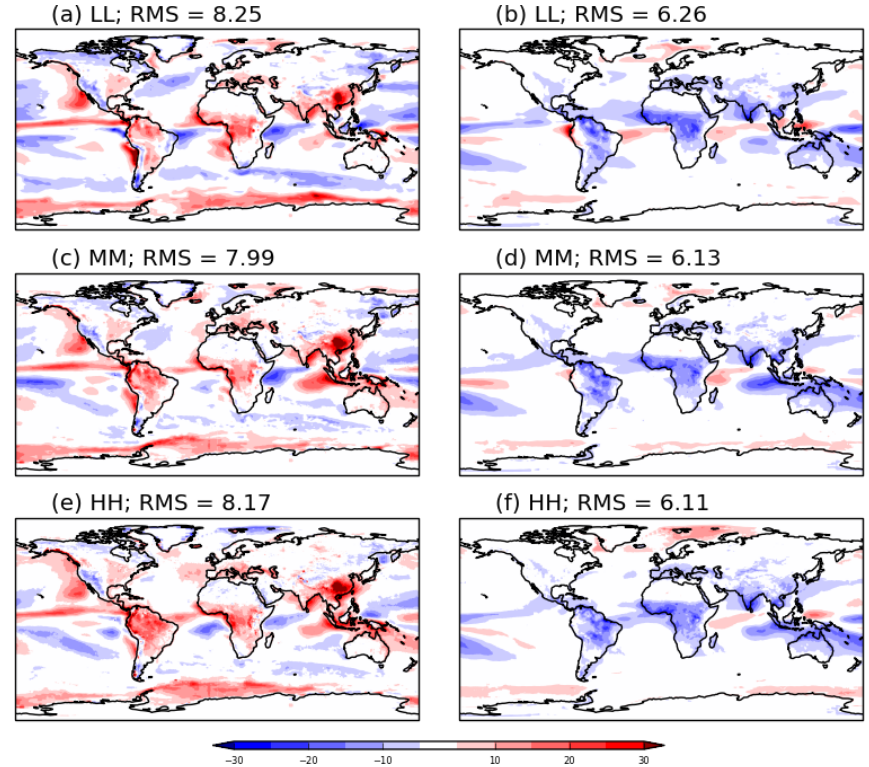
Figure 4. Annual mean model bias over years 50–100 in cloud radiative forcing (Wm − 2 ) for (a, c, e) shortwave cloud forcing and (b, d, f) longwave cloud forcing, compared to CERES-EBAF observations for 2000–2018 (Kato et al.,